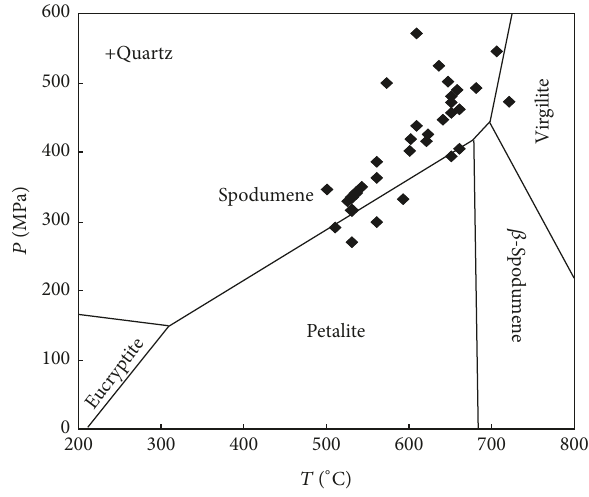
Figure 11: 𝑃 - 𝑇 conditions in the HDAC during the total homoge- nization temperatures of CIs ( 𝑇 ). Note that these are not the 𝑃 - TD 𝑇 conditions in the CIs (for details, see text). The phase diagram is from London [26] for the system LiAlSiO 4 -SiO 2 -H 2 O. The plotted pressures are the 𝑃 values listed in Table TD